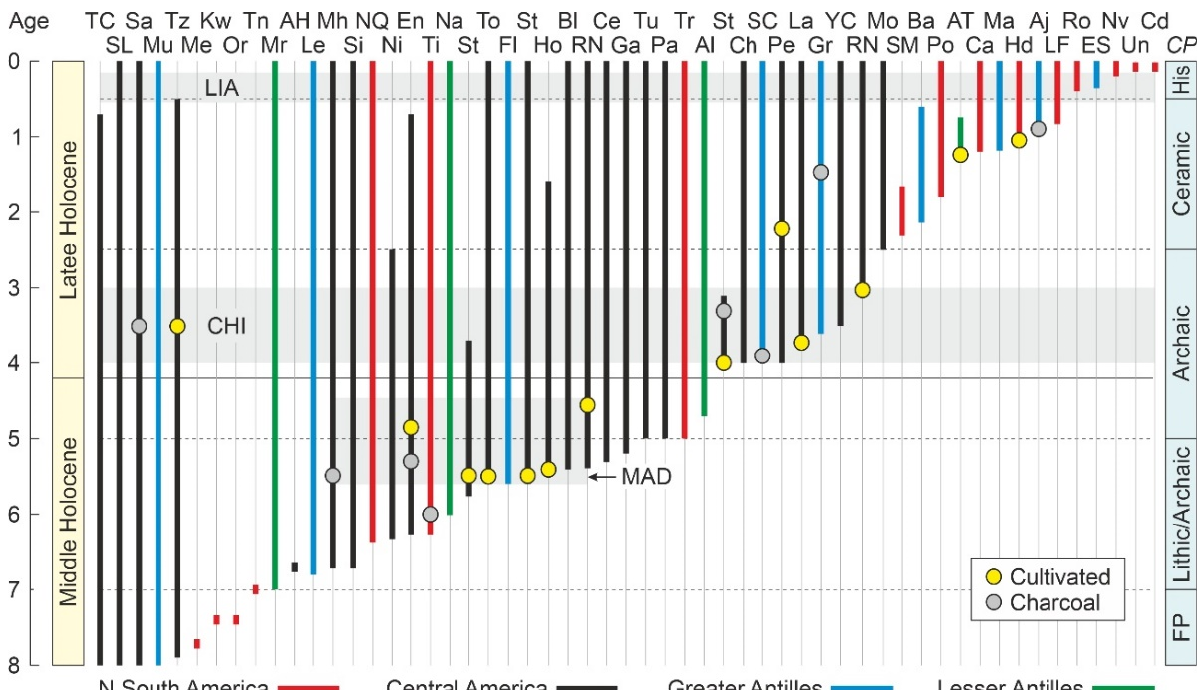
Figure 15. Holocene pollen records sorted by oldest date (time scale in cal yr BP). The different continental and insular Caribbean coasts are indicated by line colors. Yellow dots indicate the first appearances of pollen/phytoliths from cultivated plants, and gray dots mark the onset of significant/continuous charcoal records. Data and abbreviations from Table 3 (see Figure 12 for location). CHI, Cariaco Holocene Instability event; CP , Cultural Phases; His, Historical period; MAD, Mesoamerican Archaic Disturbance event.